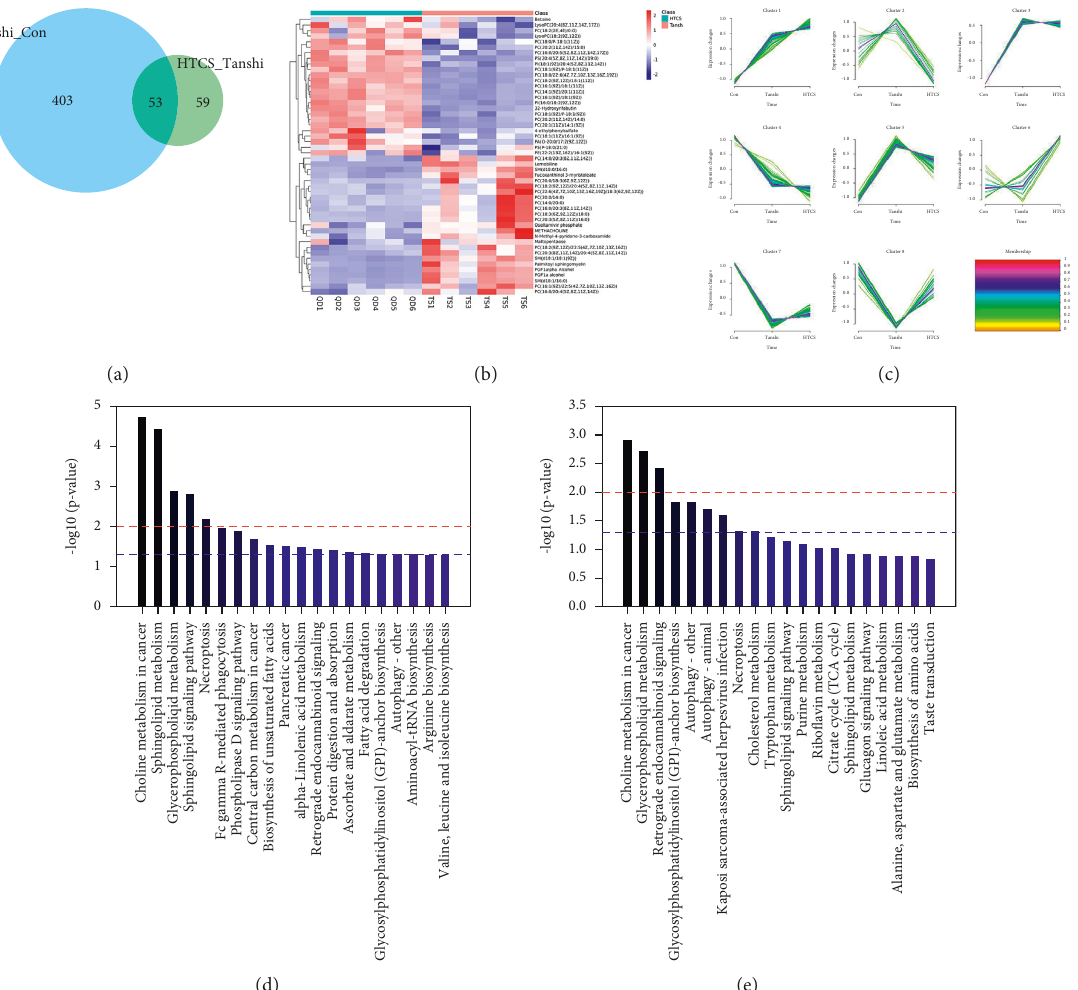
Figure 4: Serum metabolism profile alterations and metabolite-associated pathways. (a) The amount of differential metabolites among the experimental groups. (b) Heatmap of top 50 differential metabolites in the HTCSD vs Tanshi group. (c) Clusters of time sequence analysis of differential metabolites among the experimental groups. (d) The column chart of the top 20 KEGG pathways in the Tanshi vs control group. (e) The column chart of the top 20 KEGG pathways in the HTCSD vs Tanshi group. Abbreviations: HTCSD :Huo-Tan-Chu-Shi